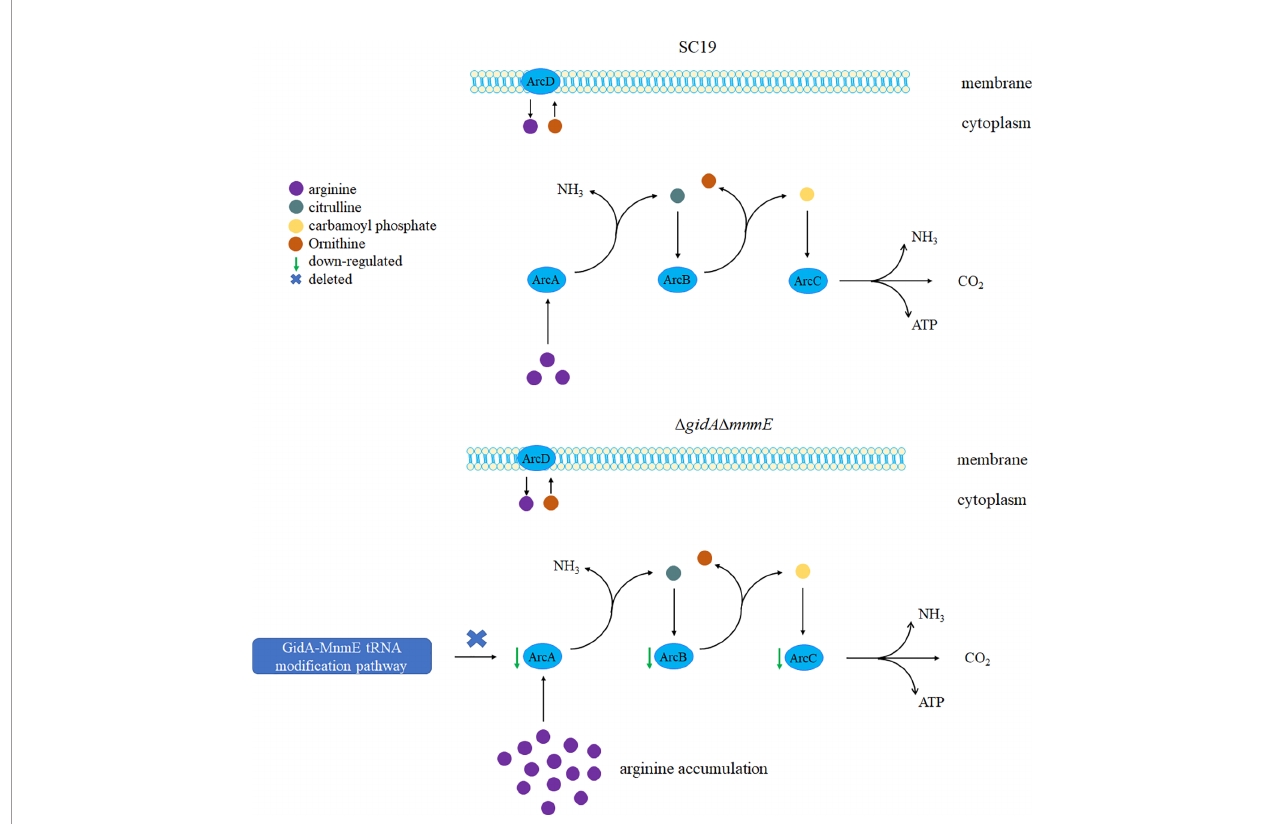
FIGURE 6 | A proposed model for molecular mechanism on arginine metabolism perturbation by GidA-MnmE modi fi cation